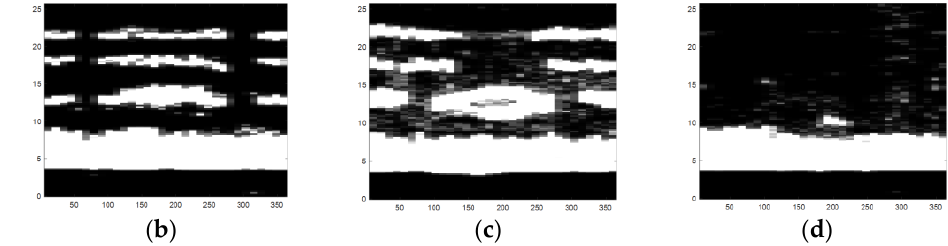
Figure 12. The defect images processed by the combination of Laplacian operator and bilateral fil- tering: ( a ) small crack, ( b ) transverse crack, ( c ) hole defect, and ( d ) chapped defect.